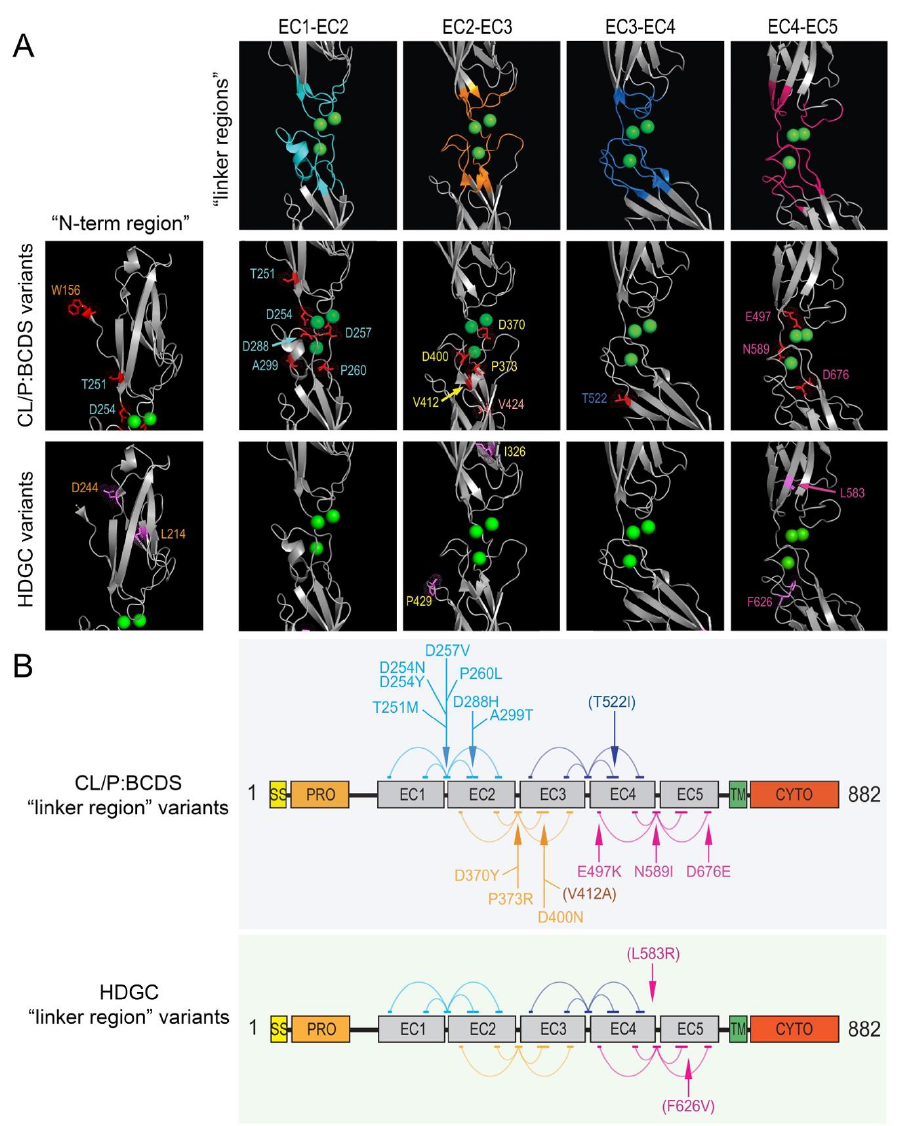
Figure 4. Most pathogenic / likely pathogenic CL / P missense variants, but very few HDGC variants, cluster in the linker regions between the extracellular domains of E-cadherin. ( A ) Residues contributing to each linker are colored on the 3D structure (upper panel in ( A )) in teal (EC1-EC2 linker), orange (EC2-EC3 linker), blue (EC3-EC4 linker), and pink (EC4-EC5 linker). The locations of pathogenic / likely pathogenic missense CL / P variants (middle panel) and missense HDGC variants (lower panel) that map to near the respective 3D linker region structures are shown (colored and labeled). ( B ) Schematic of the E-cadherin primary sequence showing the di ff erent domains (rectangles): SS—single sequence; PRO—pro domain; EC1–5—extracellular domains 1–5; TM—transmembrane domain; CYTO—cytoplasmic (intracellular) domain. A total of 15 of the 17 CL / P missense variants found within the extracellular region (and 15 of 19 total) are part of, or one residue adjacent to, the linker regions marked by arrows, as compared to only three (L583R and both F626V) of the 11 HDGC variants. Note: five distinct clusters of amino acids (horizontal colored lines joined by arcs in the schematic), spread across the primary sequence of two adjacent EC domains (grey rectangles) contribute to each of the respective linker regions in the 3D protein structure. As in ( A ), the clusters of amino acid residues in the schematic are colored in teal, orange, blue, and pink for those contributing to the EC1-EC2 linker, EC2-EC3 linker, EC3-EC4 linker, and EC4-EC5 linker, respectively. The variants indicated in brackets in ( B ), reside immediately adjacent a defined